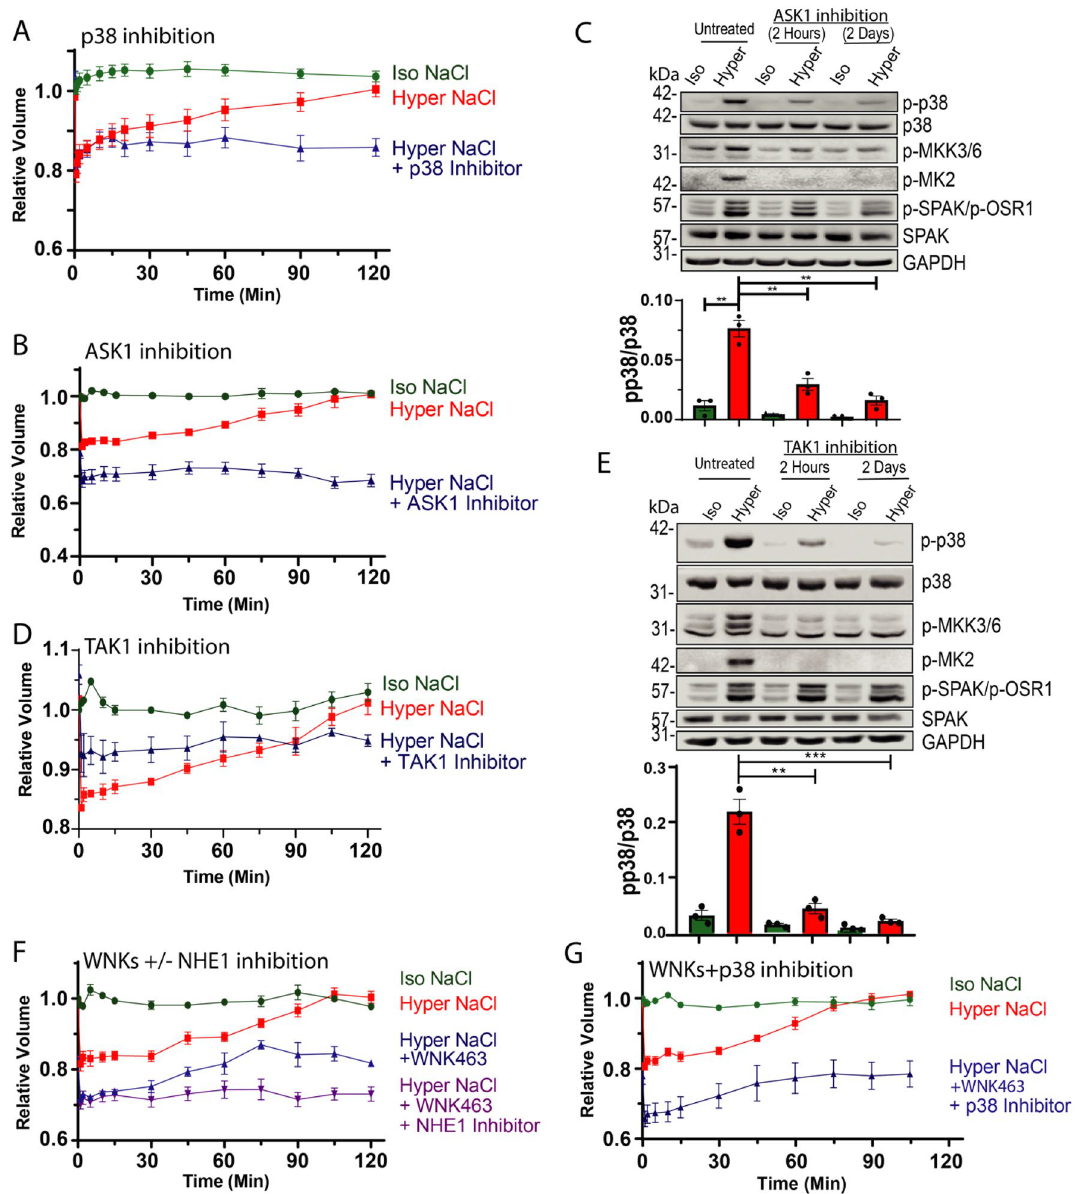
Figure 5. Long term p38 or WNKs inhibition (+ /− NHE1 inhibition) attenuates RVI. HeLa cells expressing scramble control plasmid were treated with ( A ) 5 μM SB203580 (p38 inhibitor), ( B ) 10 μM GS-444217 (ASK1 inhibitor), or ( D ) 1 μM 5Z-7-Oxozeaenol (TAK1 inhibitor) for 2 days, washed with PBS and exposed to iso- or hyper- osmotic NaCl solution in the presence of the inhibitors for the indicated times. Cell volume recovery (RVI) was measured by using a Coulter Counter. HeLa scramble control cells were treated with ( C ) 10 µM GS-444217 or ( E ) 1 μM 5Z-7-Oxozeaenol for 2 h or 2 days followed by incubation of iso- or hyper- osmotic NaCl solutions in the presence/absence of GS-444217 or 5Z-7-Oxozeaenol. Quantification of active p38 (p-p38) is depicted below their respective blots. ( F ) HeLa scramble control cells were treated with 10 μM WNK463 for 2 days with or without 30 min treatment of 10 μM Cariporide (NHE1 inhibitor). ( G ) HeLa scramble control cells were treated with 5 μM SB203580 and 10 μM WNK463 for 2 days. ( F, G ) After treatment with the indicated inhibitors, cells were washed with PBS and exposed to iso- or hyper- osmotic NaCl solution in the presence of the indicated inhibitors for the indicated times. RVI was measured as above. All data are mean ± s.e.m, N ≥ 3 independent experiments. Statistics as described in Fig.